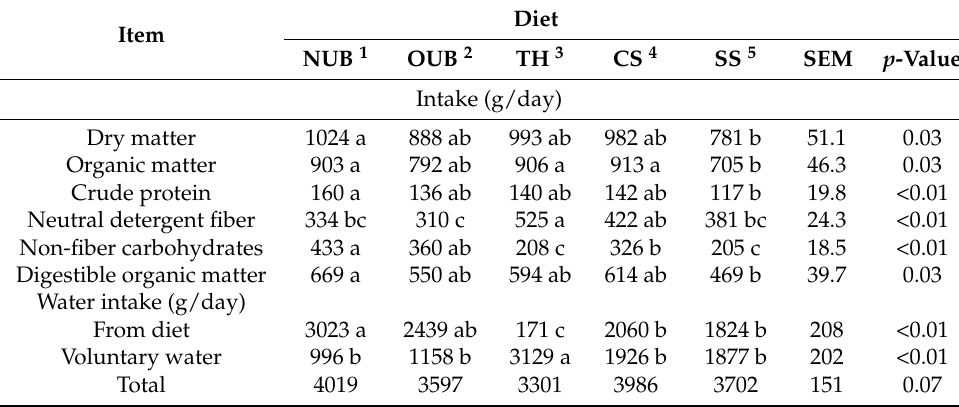
Table 3. Nutrient and water intake for sheep fed different